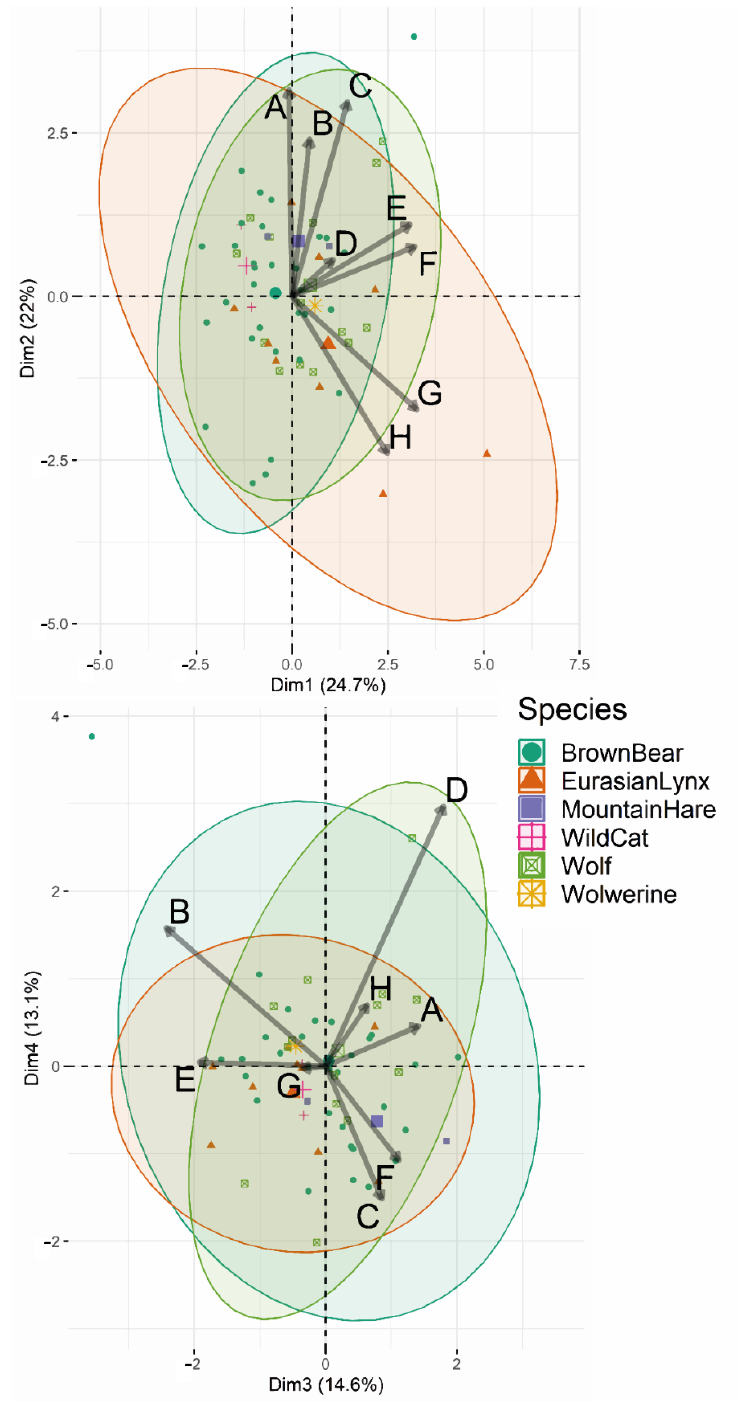
Figure 4. Biplot of variables and individuals classed by studied species (PSD – PCA).